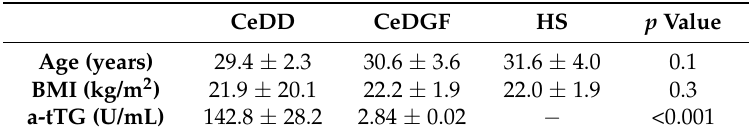
Table 2. Characteristics of study